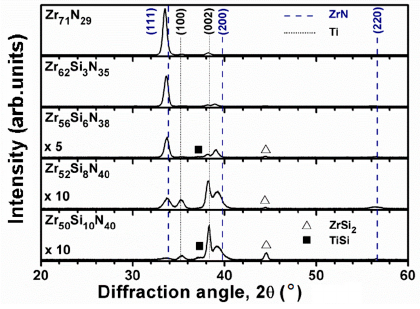
Figure 6. Bragg–Brentano scan X ‐ ray diffraction (XRD) patterns of Zr–Si–N films with a Ti interlayer.